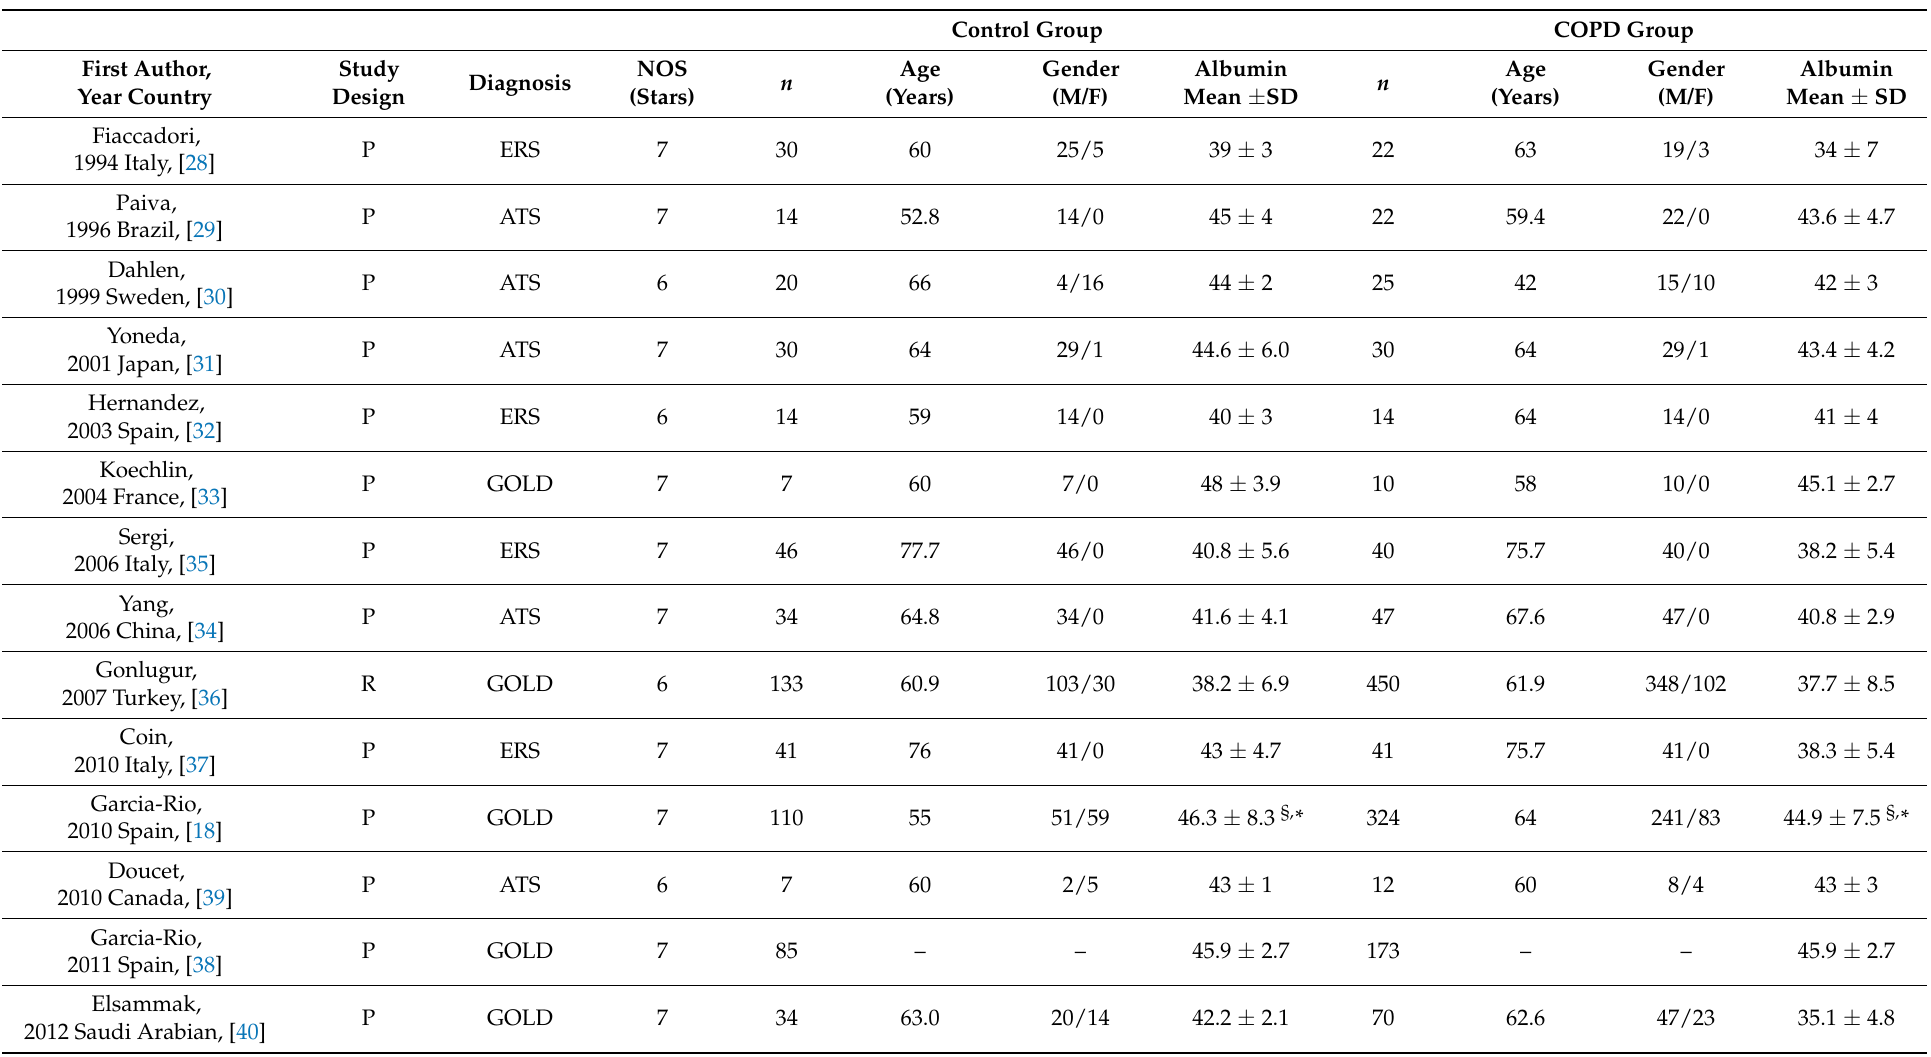
Table 1. Summary of the studies on COPD vs. controls included in the meta-analysis. Control Group COPD